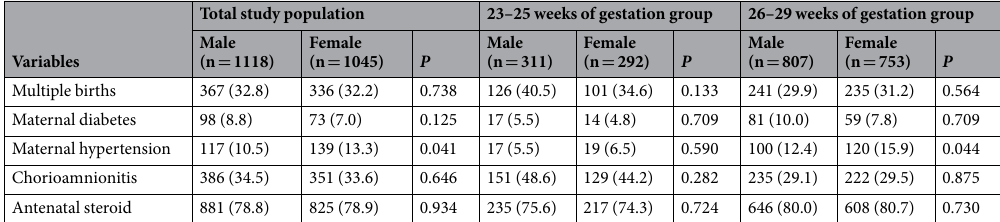
Table 2. Infants’ sex difference in maternal records according to gestational age group. Data are presented as n